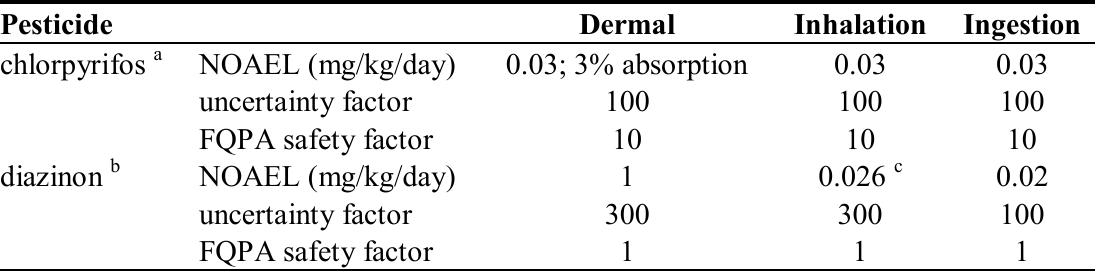
Table 4. Toxicity endpoints, uncertainty and FQPA safety factors for calculation of aggregate and route-specific risk from chlorpyrifos and diazinon exposure.